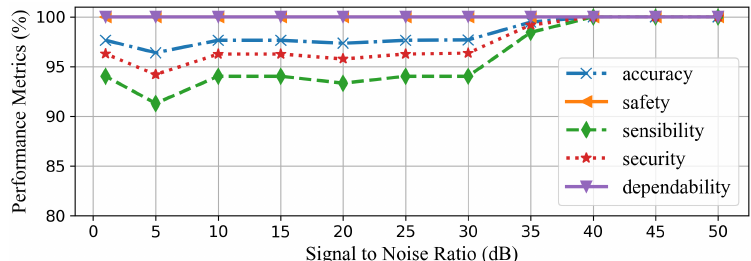
Figure 19. Effect of noise on the CAE-HIFD performance.